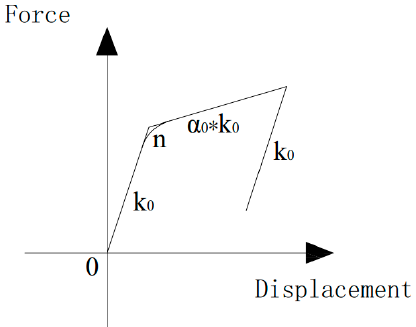
Figure 1. Schematic diagram of the Bouc – Wen hysteresis.